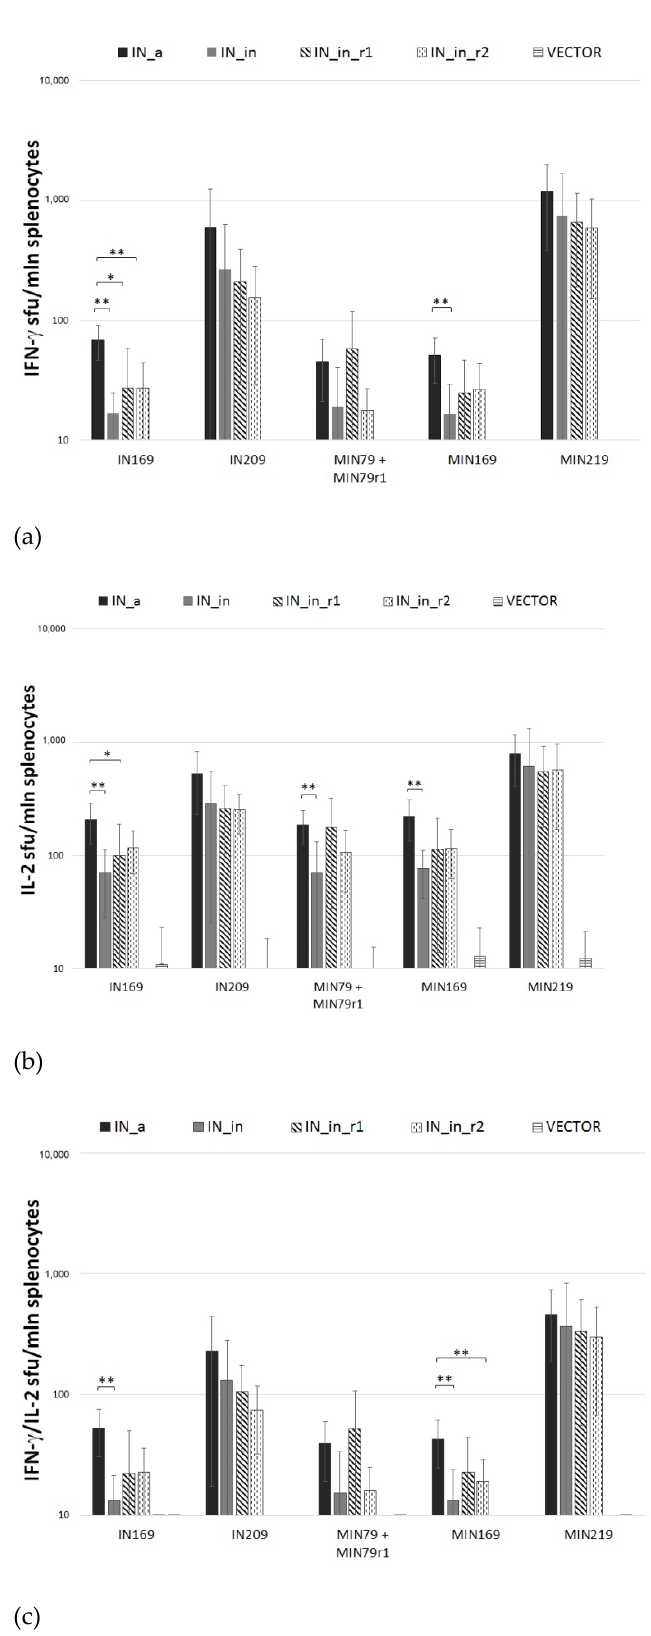
Figure 9. Splenocytes of mice DNA immunized with IN variants produce IFN- γ /IL-2 in response to stimulation with IN peptides in Fluorospot assay. Mice ( n = 4) were immunized with single injections of pVax1-based plasmids encoding consensus IN of HIV-1 clade A (IN_a), inactivated IN (IN_in), inactivated IN with mutations conferring resistance to raltegravir (IN_in_r1, IN_in_r2), or